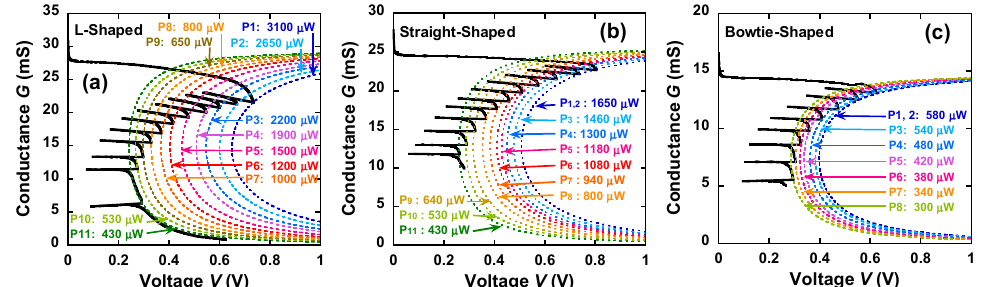
Figure 5. G as a function of the total voltage V for the ( a ) L-shaped, ( b ) straight-shaped, and ( c ) bowtie- shaped nanowires during FCE. The dashed lines indicate the fitting results of the Joule heating model.